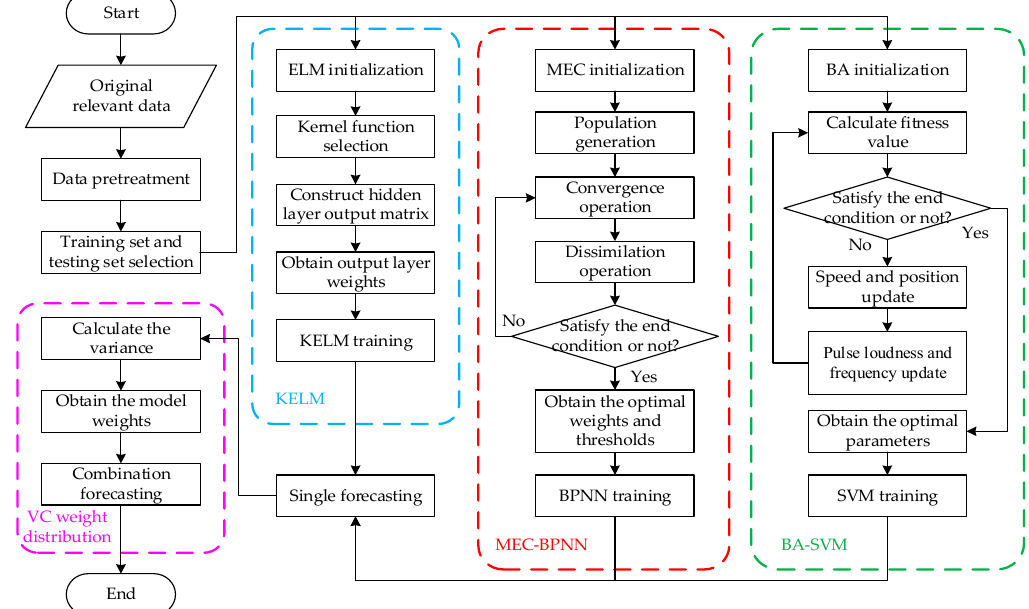
Figure 1. Combination forecasting model.